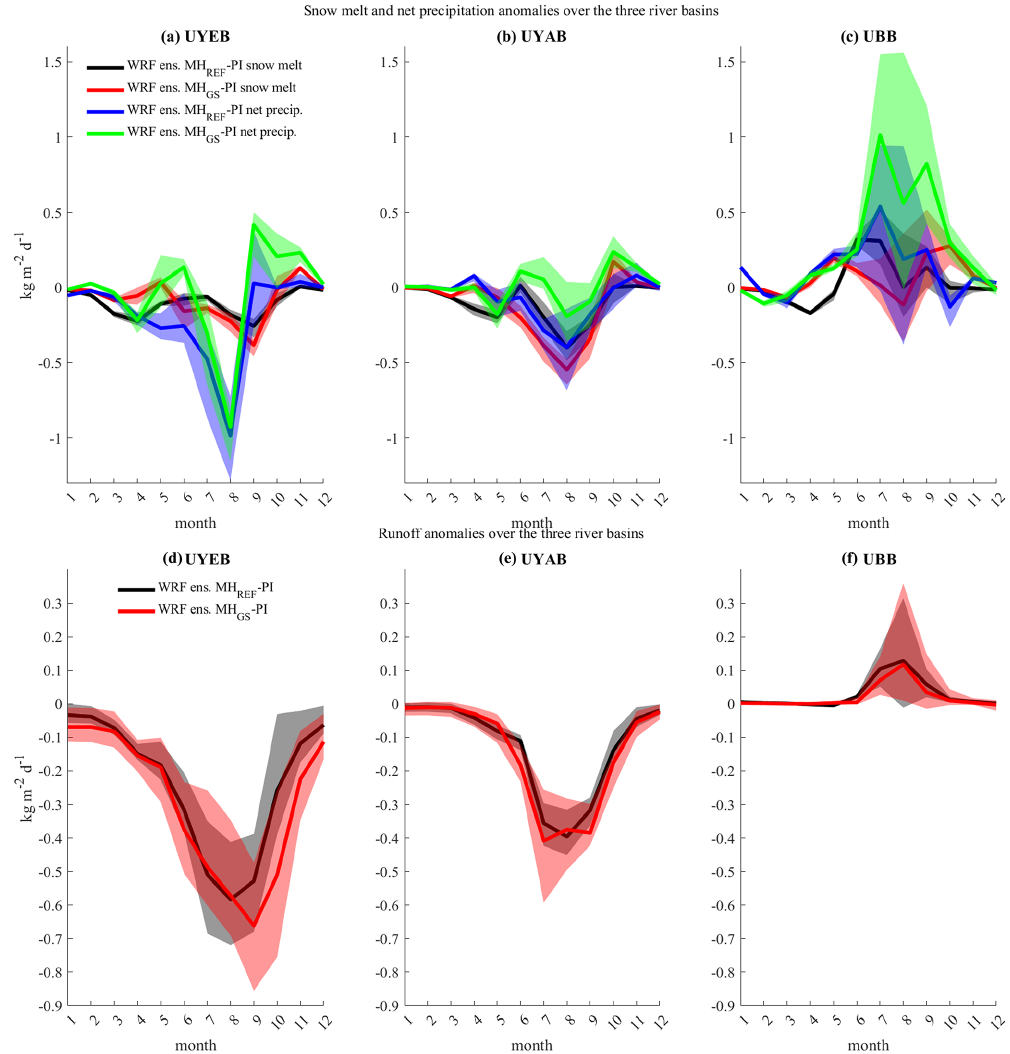
Figure 12. Monthly anomalies of (a–c) net precipitation and snowmelt and (d–f) total runoff from WRF over the three basins.